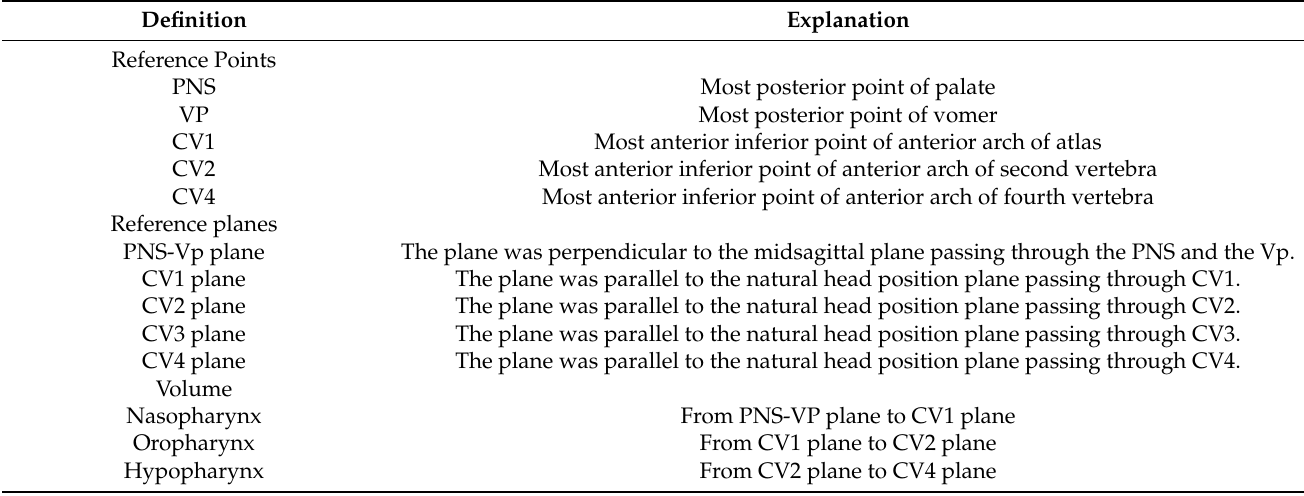
Table 1. Definition of reference points and planes for airway division. (Abbreviations: PNS, posterior nasal spine;